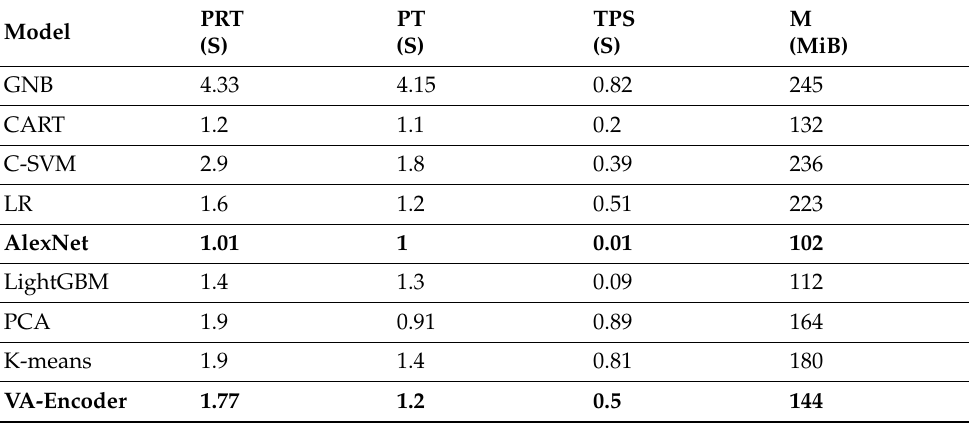
Table 4. The ML models’ performance in Terms of PRT, PT, TPS, and M for Test Data (best perfor- mances are in